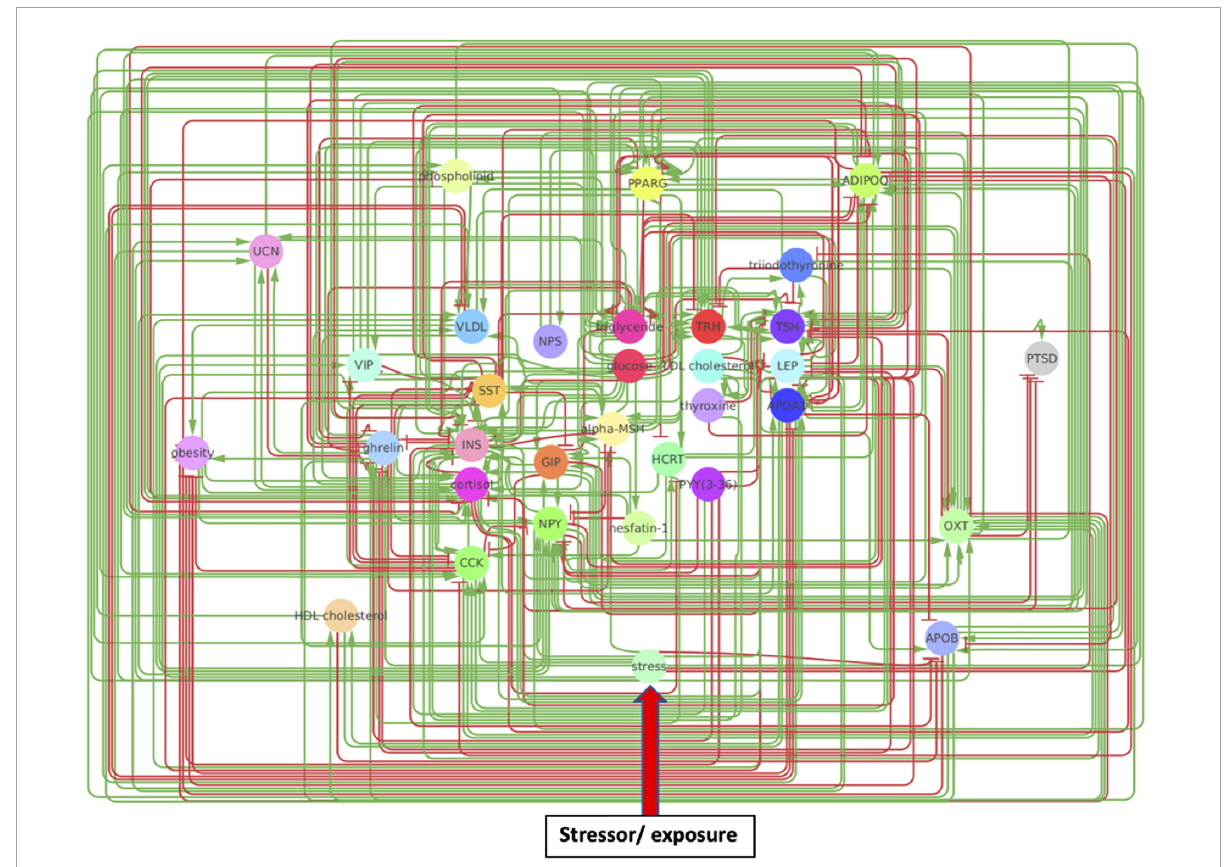
FIGURE2 A metabolic network model. Created through Pathway Studios, this model involves directional effects between metabolic markers implicated in PTSD and obesity. Arrows indicate directional regulatory edges between mechanisms, such that a green arrow indicates the source node upregulates the target node while a red arrow indicates the source node downregulates the target